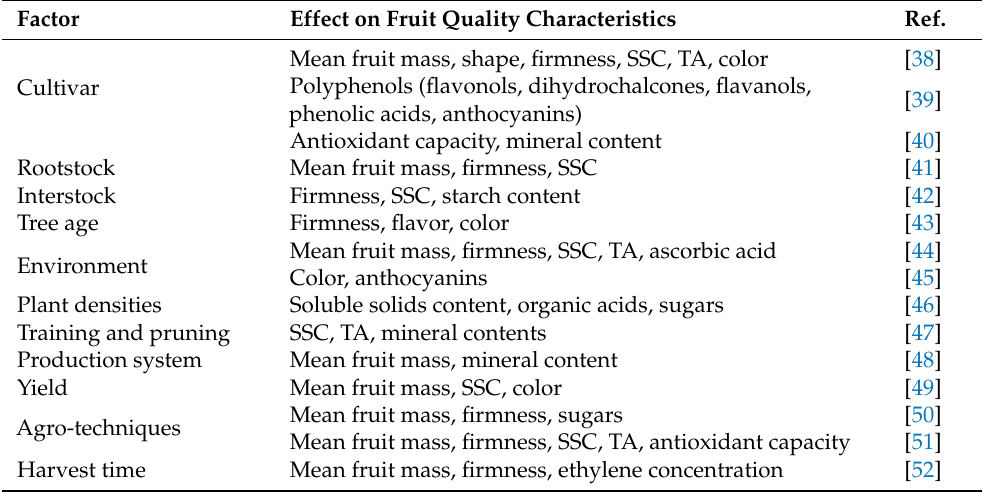
Table 1. Factors affecting apple fruit quality in sustainable